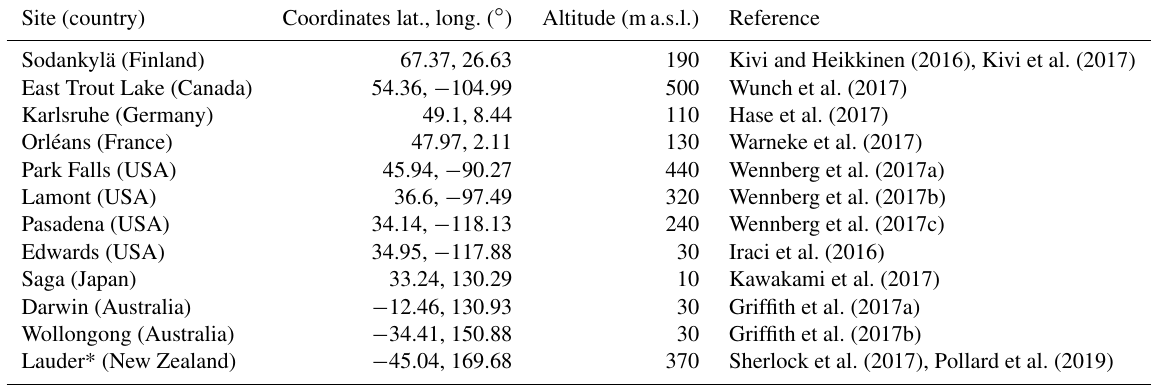
Table 1. Overview of the stations from TCCON used in this study. Site